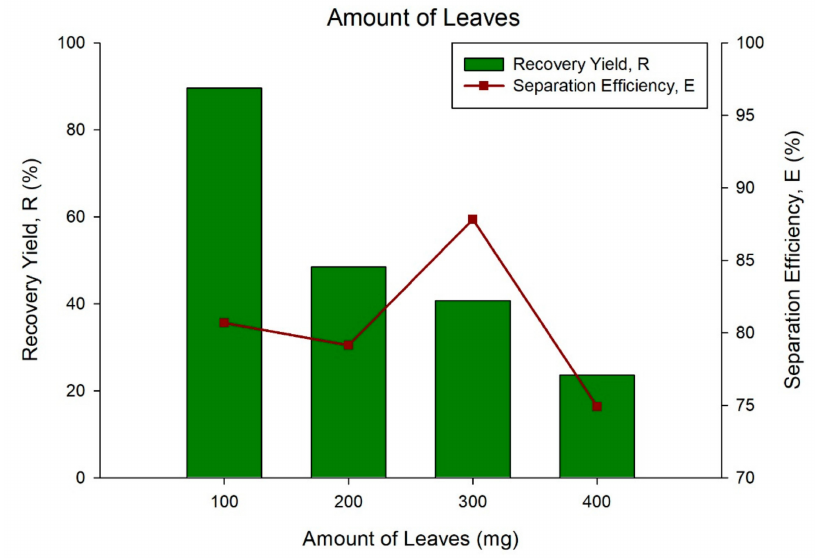
Figure 3. E ff ect of the kesum biomass amount on the protein recovery yield and separation e ffi